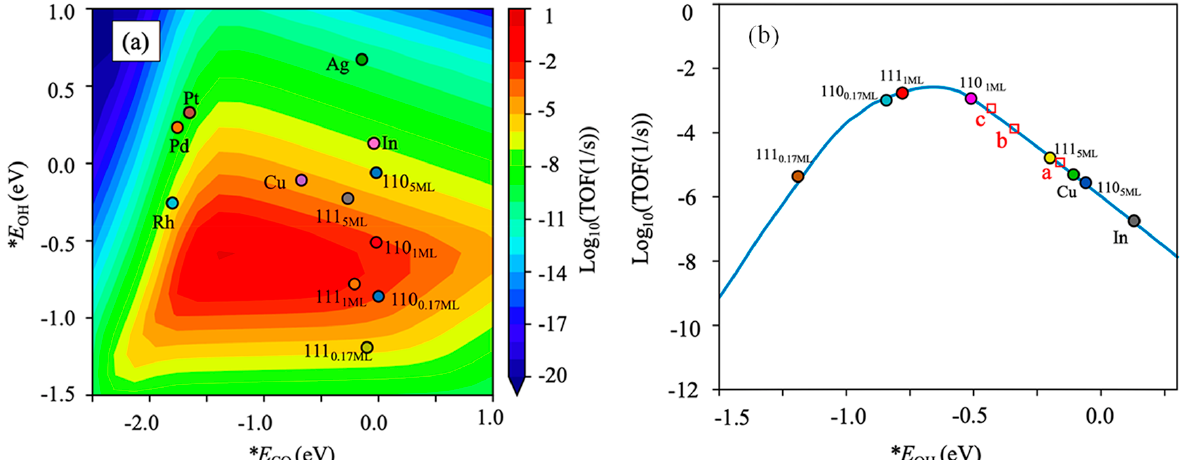
Figure 3. ( a ) Theoretical activity volcano of methanol synthesis from CO 2 hydrogenation over In 2 O 3 and transition-metal (211) surfaces. ( b ) The relationship between methanol formation and OH binding energy (fixed CO adsorption energy: − 0.1 eV). Reproduced with permission from ref. [65]. Copyright 2021 American Chemical Society.